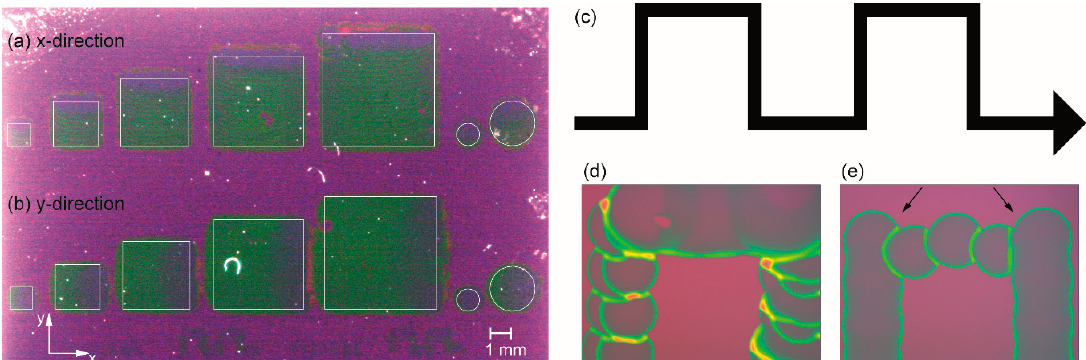
Figure 10. Print results on SiO 2 /Si depending on the main print direction for different features. Left: Photograph showing the results for different areas. The thin white squares (1, 2, 3, 4, and 5 mm 2 ) and circles (Ø = 1 and 2 mm) indicate the theoretical areas given by the PC template. ( a ) Printing in the x-direction. ( b ) Printing in the y-direction. Right: Sections of an ∩ -type line (schematic part of the template in ( c ); not to scale) nominally printed by 100 µm dots with a resolution of 250 dots per inch (DPI). ( d ) Printing in the x-direction ( e ) Printing in the y-direction. However, there is a pronounced positional inaccuracy at the edges (arrows) which can be attributed to the movement of the as-deposited drops in the y-direction. The slightly shifted dots in the upright lines of photomicrograph ( d ) may be explained by the acceleration of the as-deposited, still flowable dots caused by the incremental movement in the y-direction before the next droplet is printed.